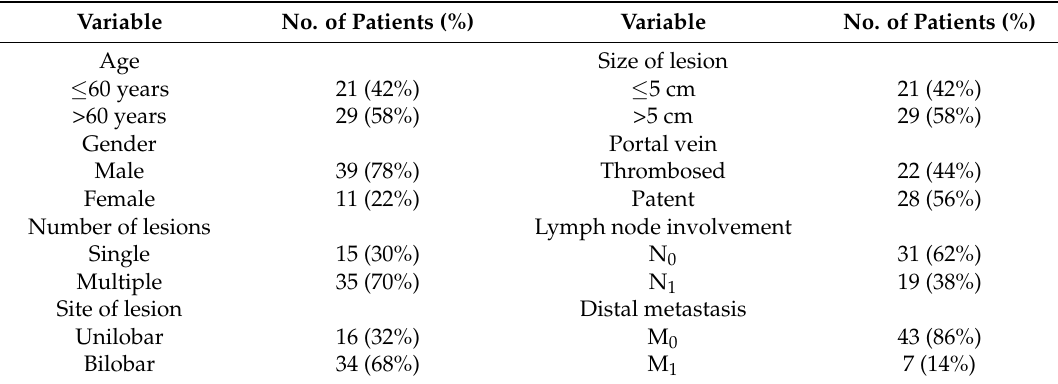
Table 1. The characteristics of 50 patients with hepatocellular carcinoma (HCC).